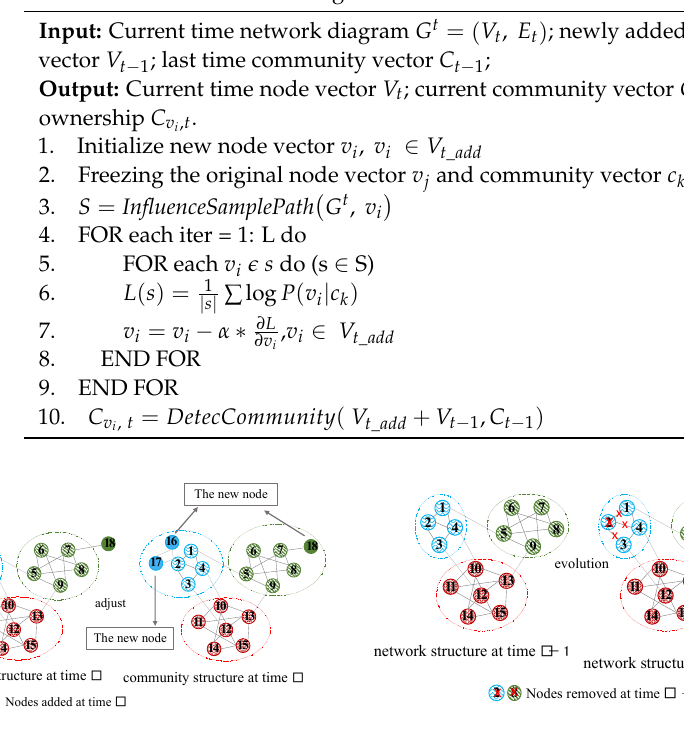
network structure at time  − 1